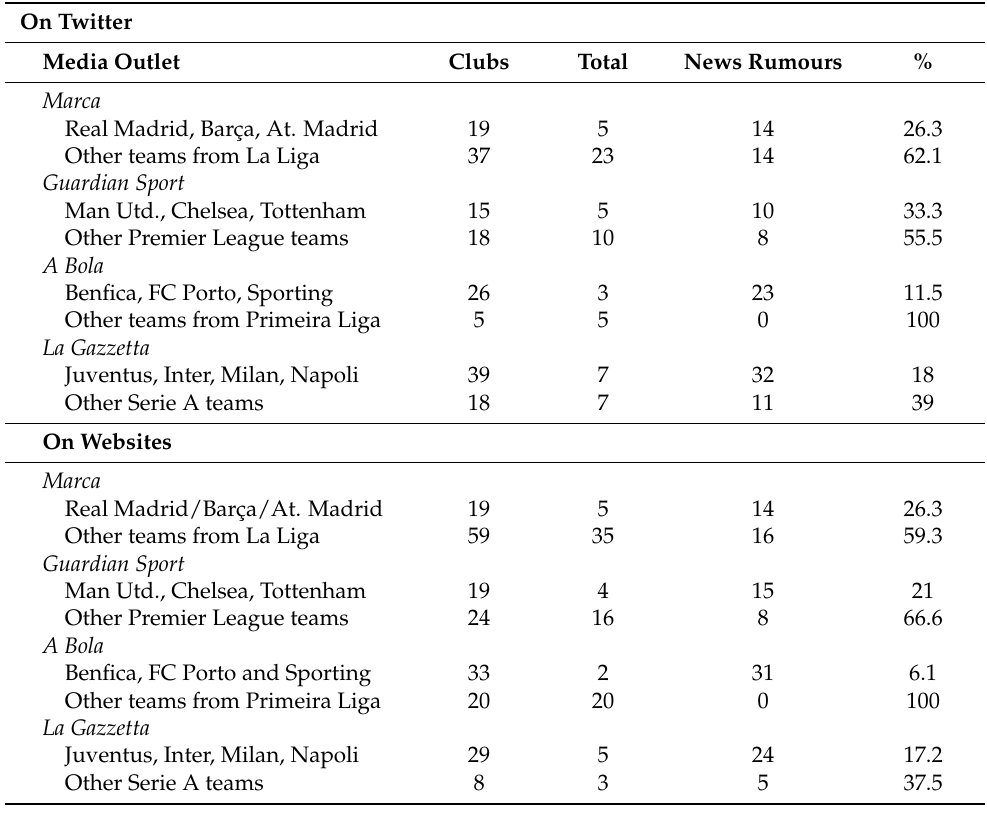
Table 5. The table shows the amount of factual reporting regarding the clubs involved in the published pieces of news and